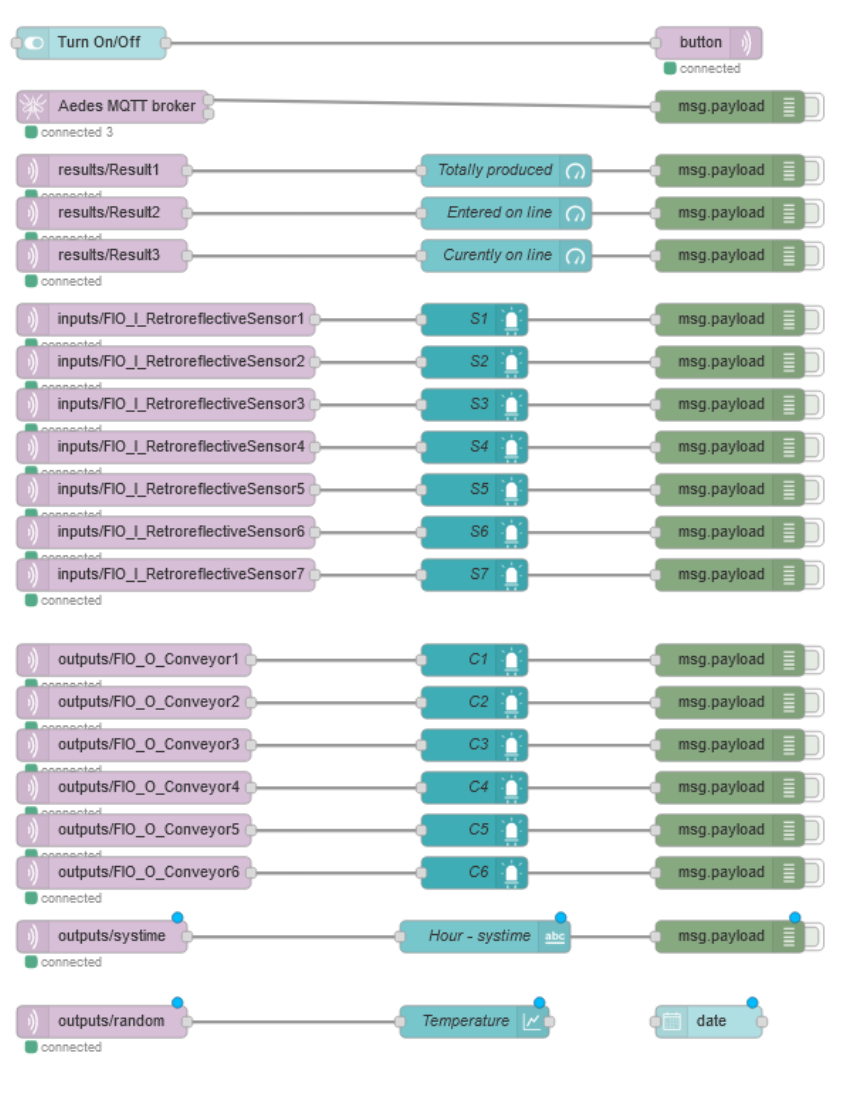
Figure 22. Node-RED in cloud. Table 2. Variables in local